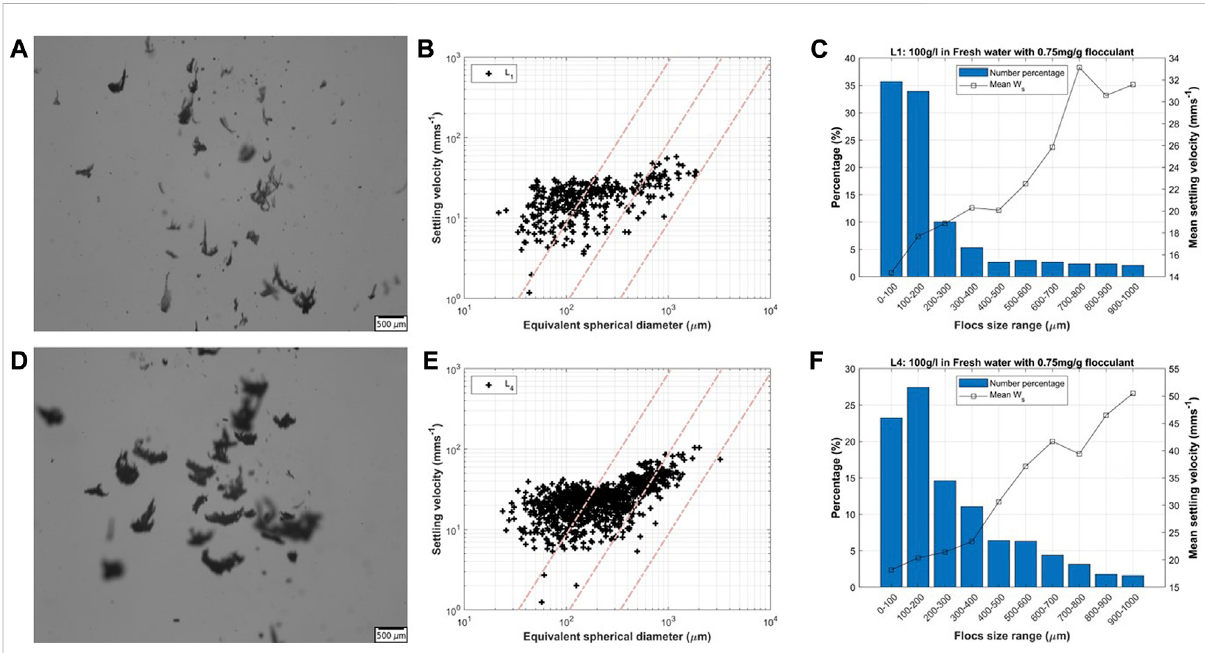
FIGURE 8 Figures (A,D) snapshots of the videos; Figures (B,E) : Settling velocity and particle size analysis of the samples collected at location L1 and L4 during lock exchange experiments with 100 g L − 1 illite and 0.75 mg g − 1 of fl occulant in freshwater. Settling velocity is derived as a function of equivalent spherical diameter, with diagonal dashed lines representing the contours of effective density calculated by using Stokes equation (from left to right: 1600, 160, 16 (kgm − 3 )). Figures (C,F) show fl oc size range and mean settling velocity.